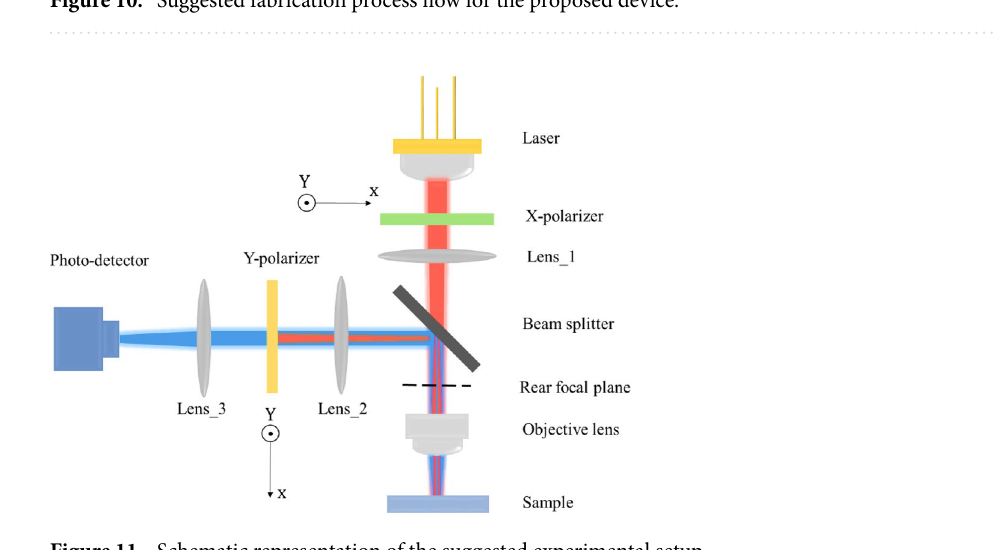
Figure 11. Schematic representation of the suggested experimental